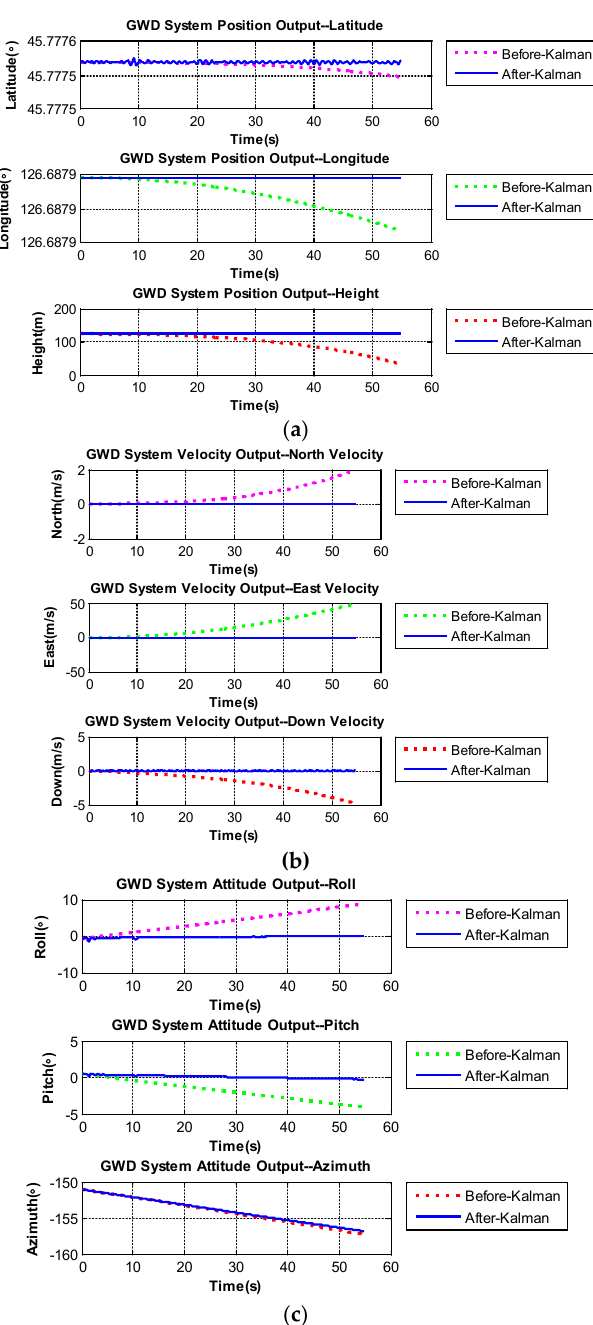
Figure 12. ( a ) MGWD system position solution with the Kalman filter; ( b ) MGWD system velocity solution with the Kalman filter; and ( c ) MGWD system attitude solution with the Kalman